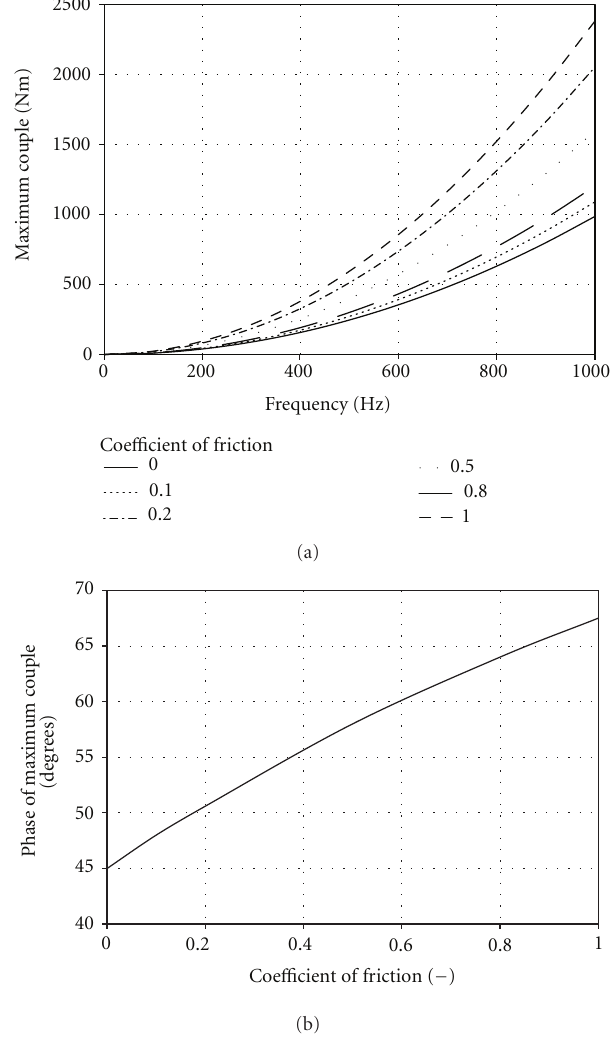
Figure 7: (a) The maximum torque that needs to be overcome to drive a connecting pin design as a function of frequency for di ff erent values of coe ffi cient of friction. (b) The phase at which the maximum torque occurs as a function of the coe ffi cient of